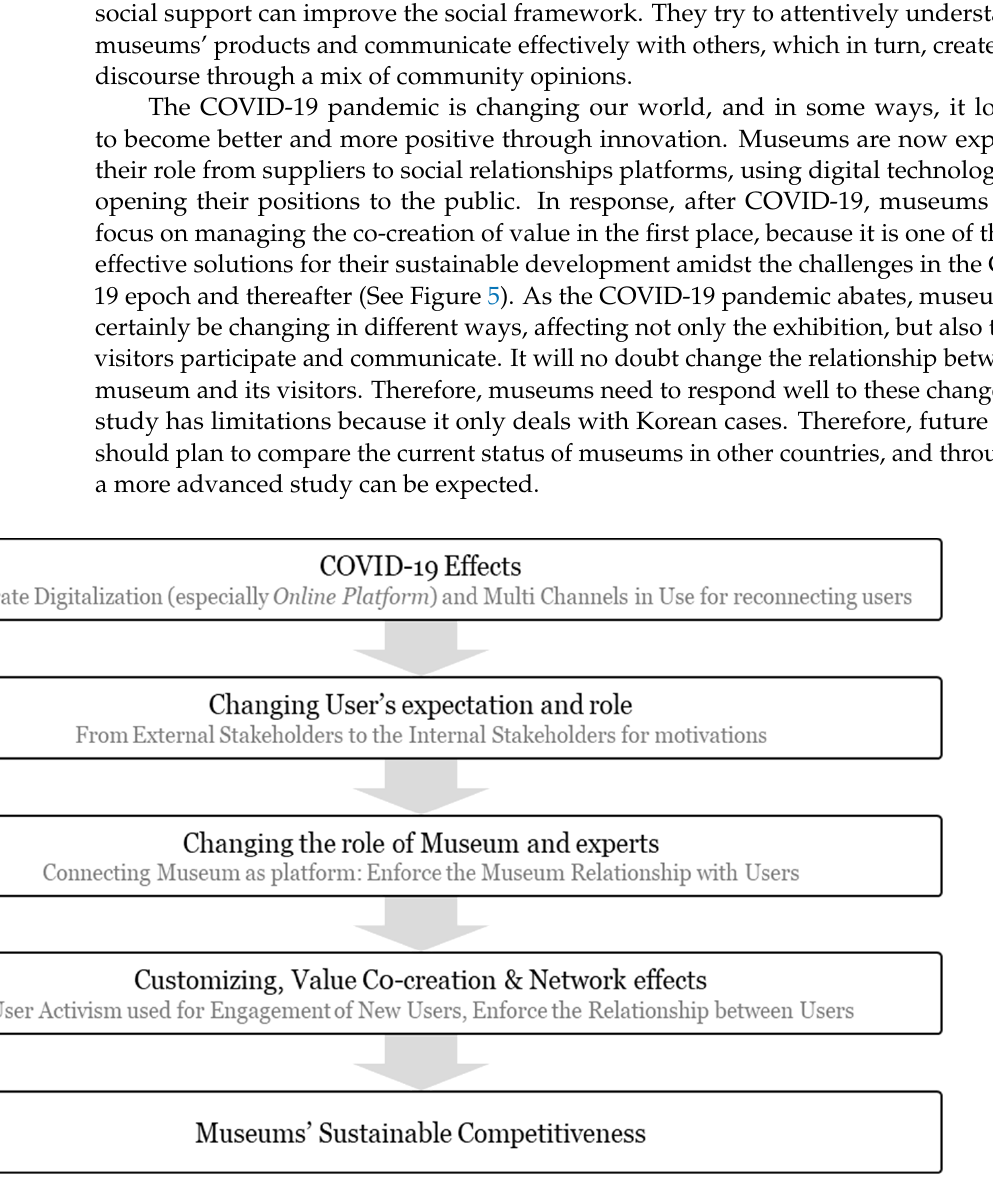
Figure 5. Sustainable competitiveness in and after the pandemic.